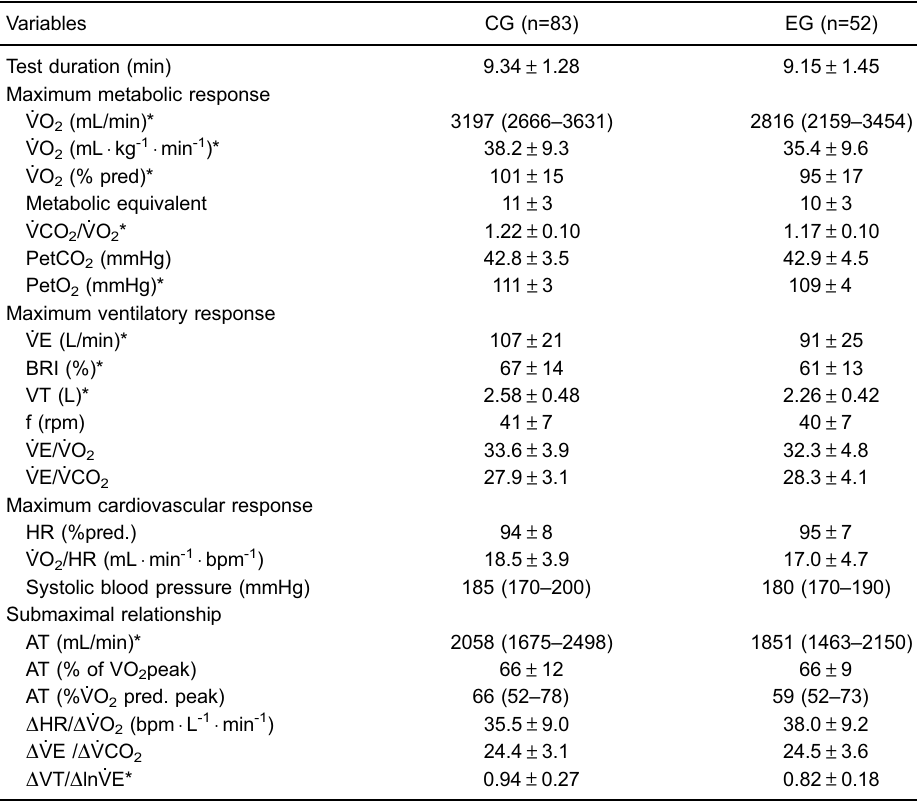
Table 3. Maximal and submaximal physiological responses obtained during cardiopulmonary exercise test in strati fi ed participants according to occupational exposure to particulate matter.